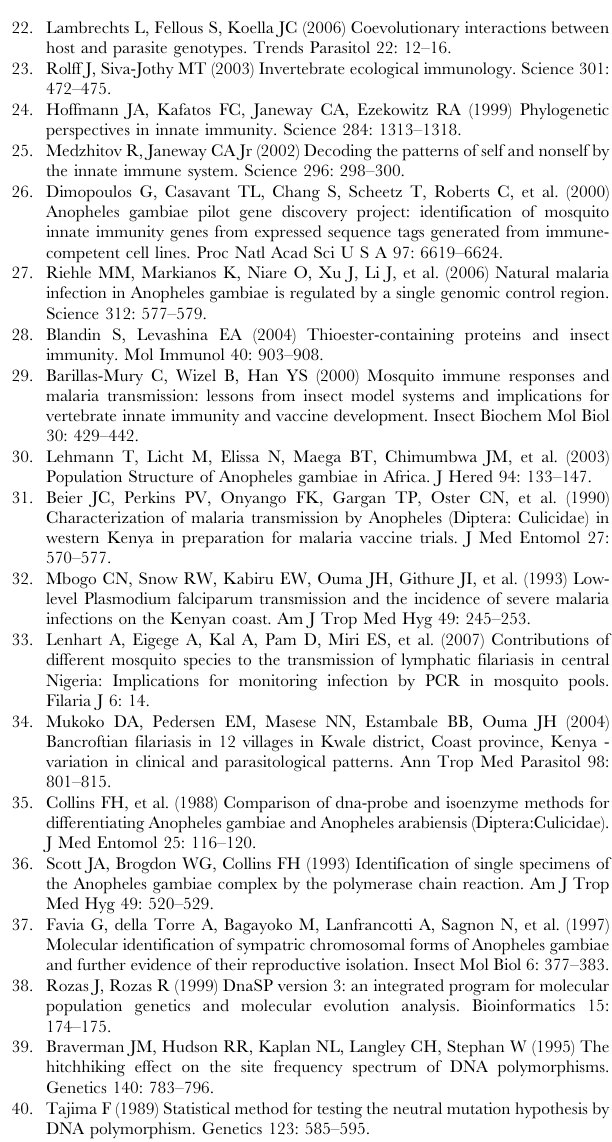
Figure S2 Alignment of polymorphic positions in AgSP14D1 after exclusion of all gaps (indels). Dots indicate identity with corresponding base of the first sequence. Position number is indicated above each base and species affiliation on the left of each sequence. Silent changes in coding regions are highlighted in gray and amino acid replacement changes are highlighted in red Found at: doi:10.1371/journal.pone.0004549.s003 (0.30 MB XLS) Figure S3 Alignment of polymorphic positions in Defensin after exclusion of all gaps (indels). Dots indicate identity with corresponding base of the first sequence. Position number is indicated above each base and species affiliation on the left of each sequence. Silent changes in coding regions are highlighted in gray and amino acid replacement changes are highlighted in red Found at: doi:10.1371/journal.pone.0004549.s004 (0.30 MB XLS)